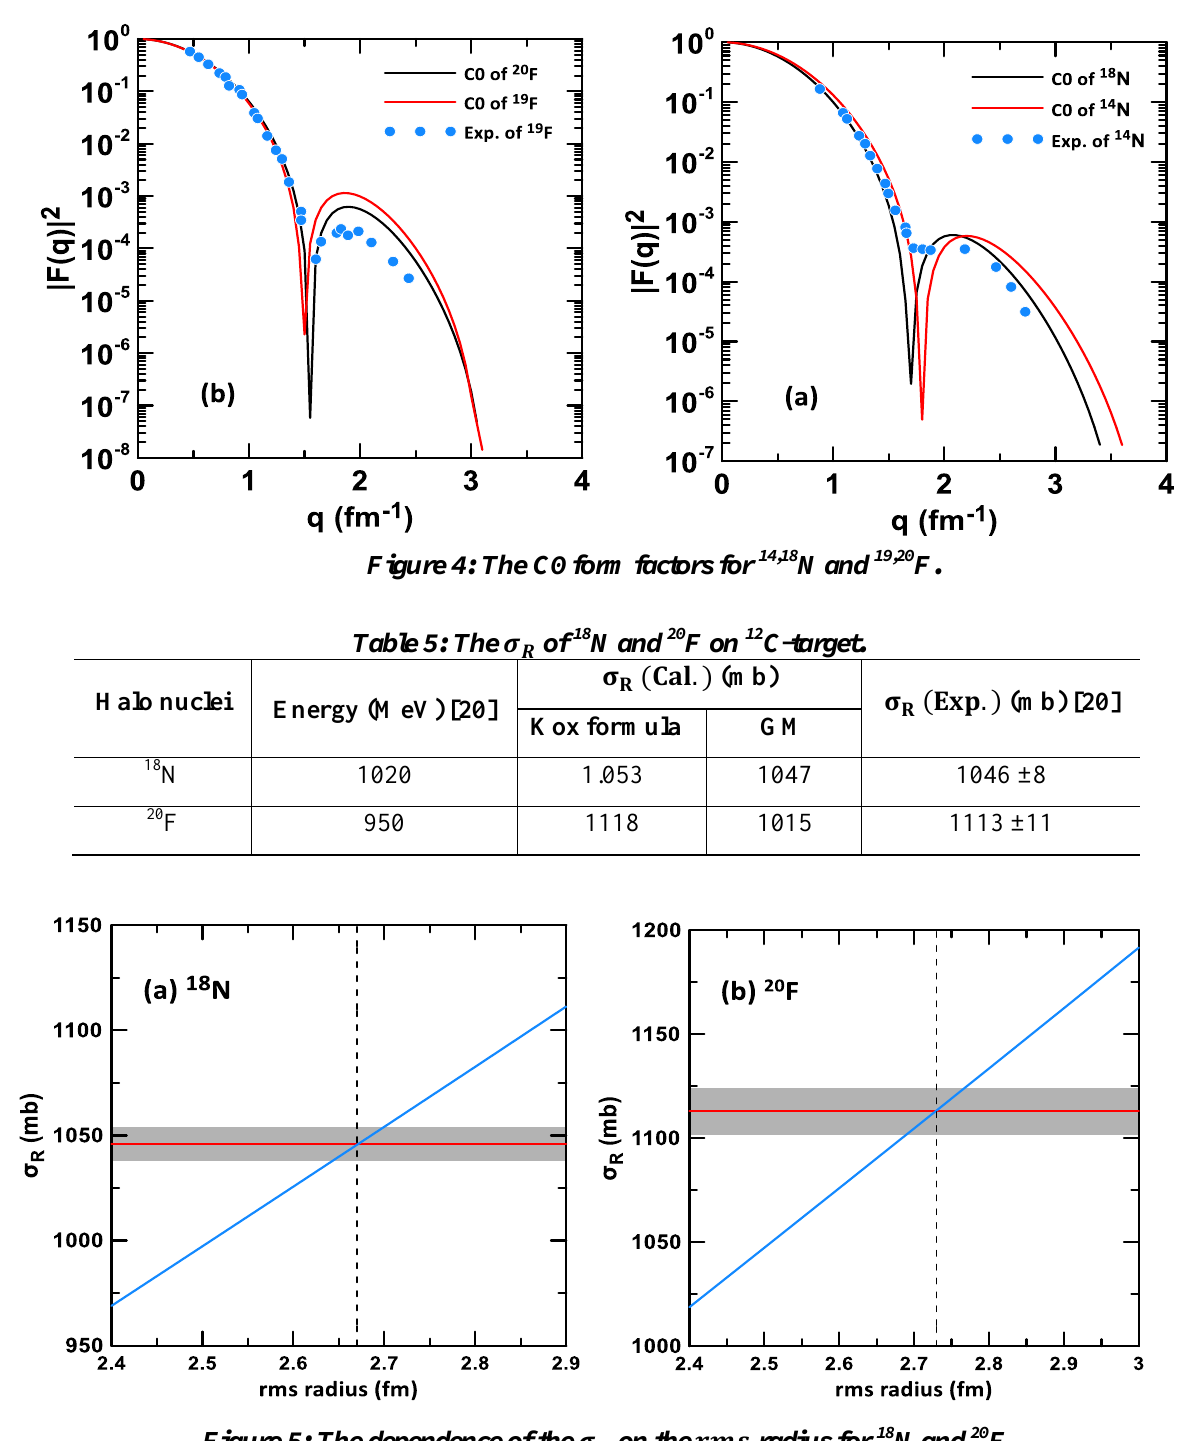
Figure 5: The dependence of the on the radius for 18 N and 20